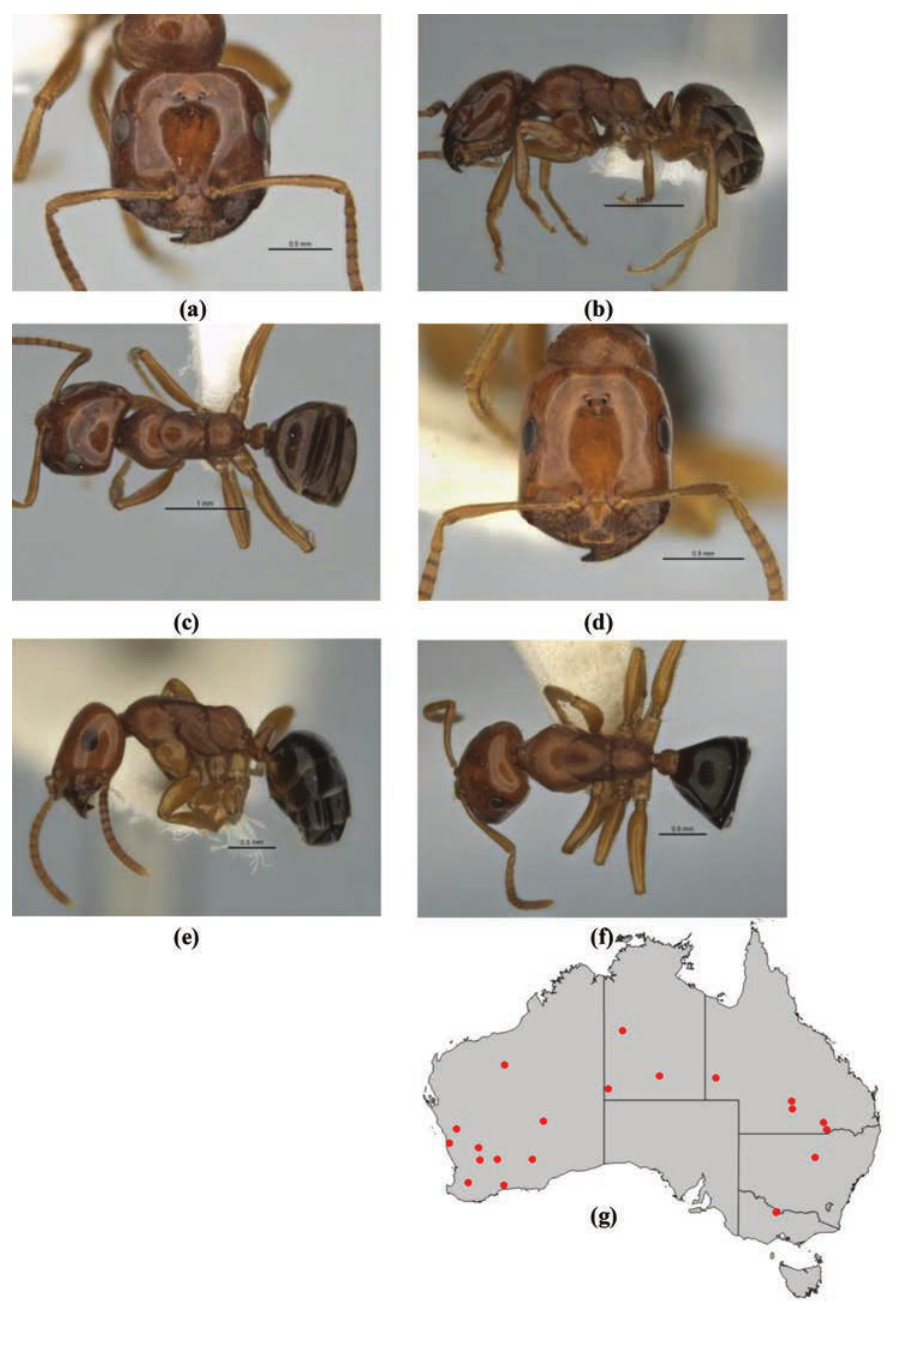
Figure 98. Melophorus potteri McAreavey: non–type major worker (ANIC32-900079) frons ( a ), pro- file ( b ) and dorsum ( c ); non–type minor worker (JDM32-001572) frons ( d ), profile ( e ) and dorsum ( f ); distribution map for the species ( g ). Low resolution scale bars: 1 mm ( b, c ); 0.5 mm ( a, d–f